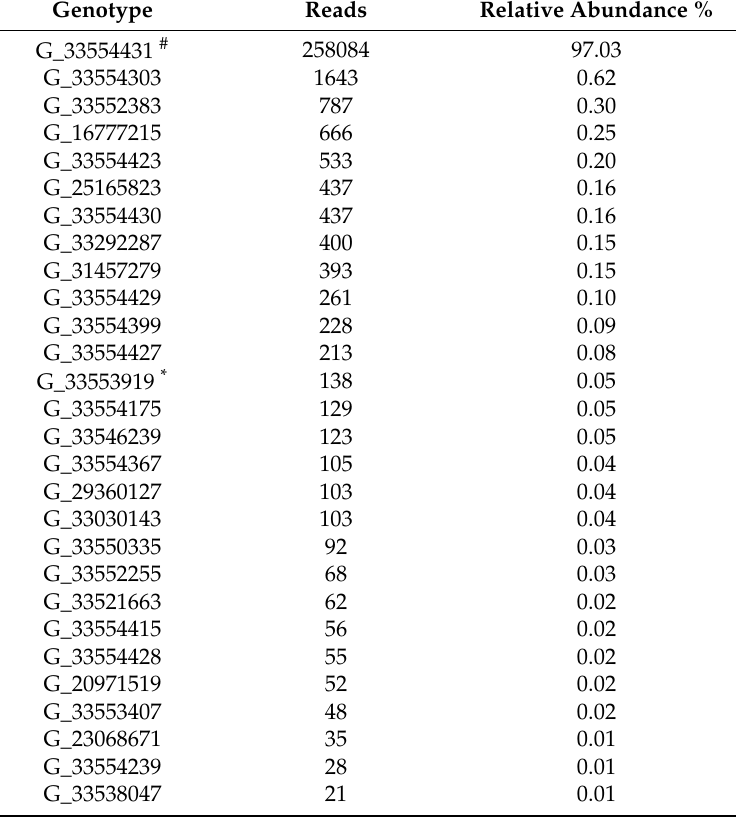
Table 2. Relative abundance of the identified AC53 BRO-A community composition that were above the 20x coverage threshold with G_33554431 identified as the dominant strain in the